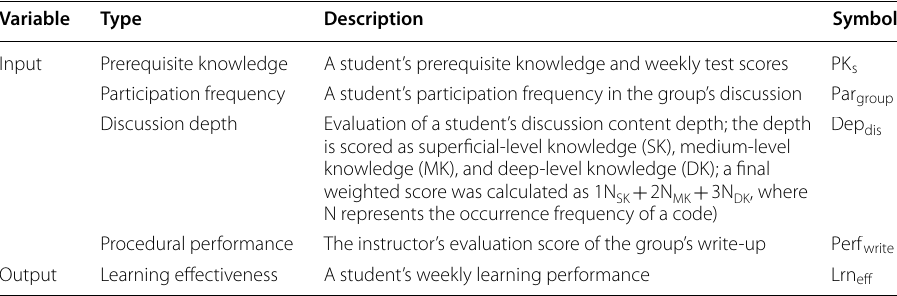
Table 1 Input and output